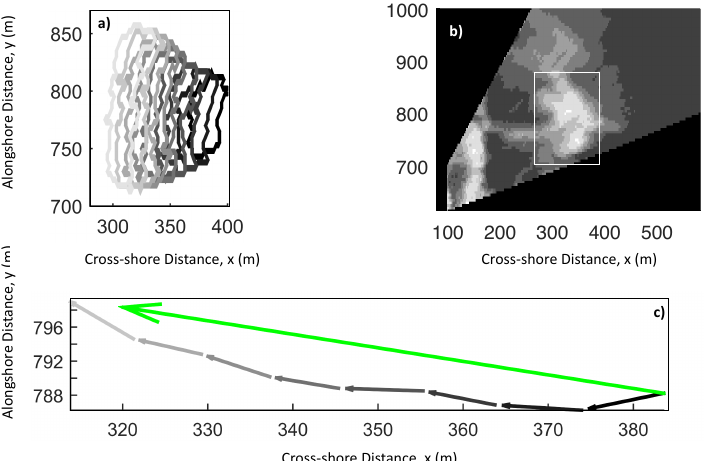
Figure 5. Example of tracking of a wave roller. ( a ) Multiple instances of the same roller as it propagates over the surf zone; ( b ) Time averaged video intensity, where the bright intensity patch corresponds to the roller history shown in a) and whose domain is indicated in the white box; ( c ) Frame by frame (shades of gray) and net change (green) in position of the roller centroid. Shaded grays denote the same roller identified in consecutive